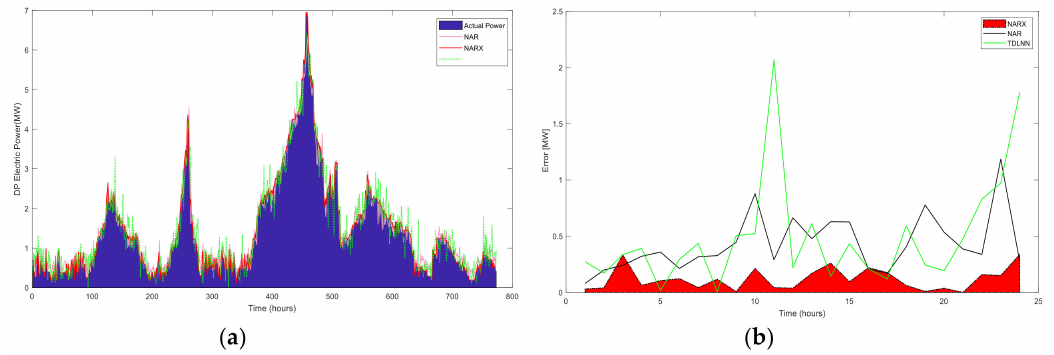
Figure 12. ( a ) The proposed method comparison in SOTLF for with 24 h lead times, and ( b ) error Percentage in